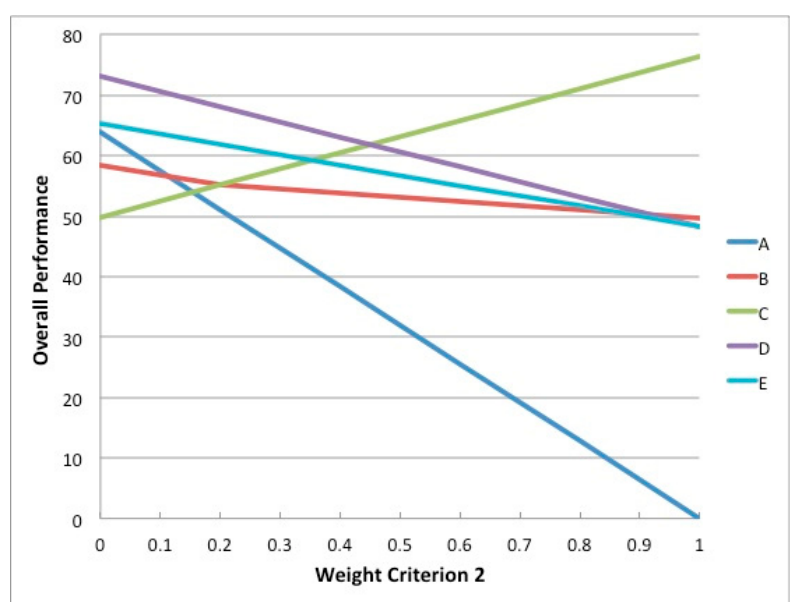
Figure 11. Sensitivity analysis targeting the weight of C2. Table 7. The analsis after adjusting the cost/budget of Plan D.